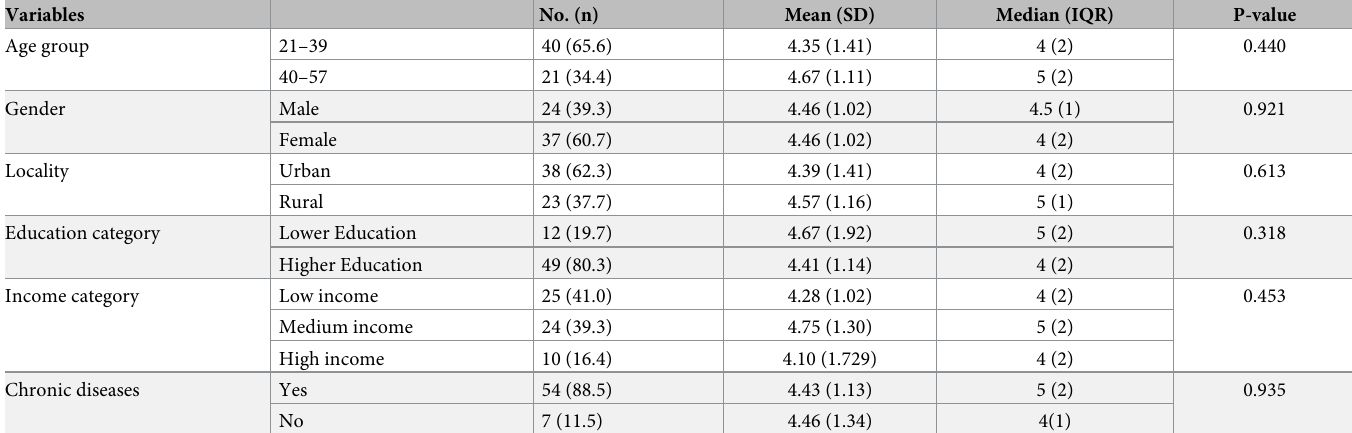
Table 2. Demographic characteristics of respondents and knowledge score ( n =